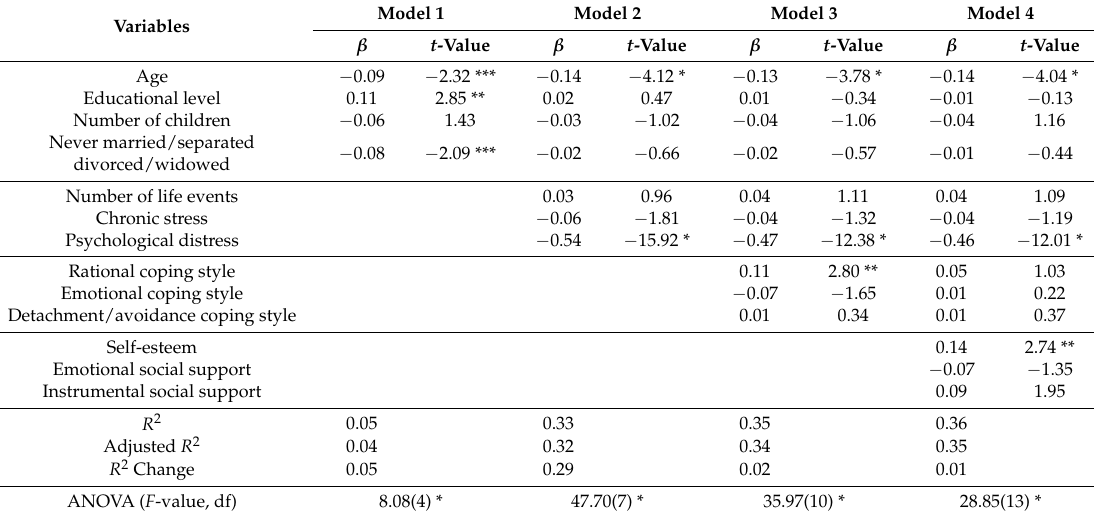
Table 6. Summary of the hierarchical regression with social functioning as the dependent variable for the women